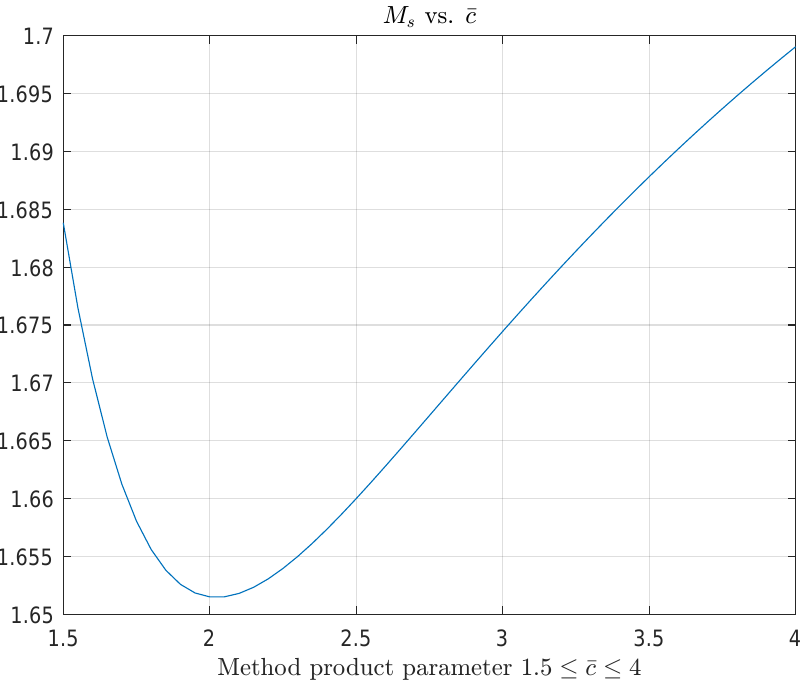
Figure 1. Consider PI control of the FOPTD process model, H p ( s ) = e − s robustness M s as a function of the MP parameter ¯ c , given constant robustness, for the interval 1.5 ≤ ¯ c ≤